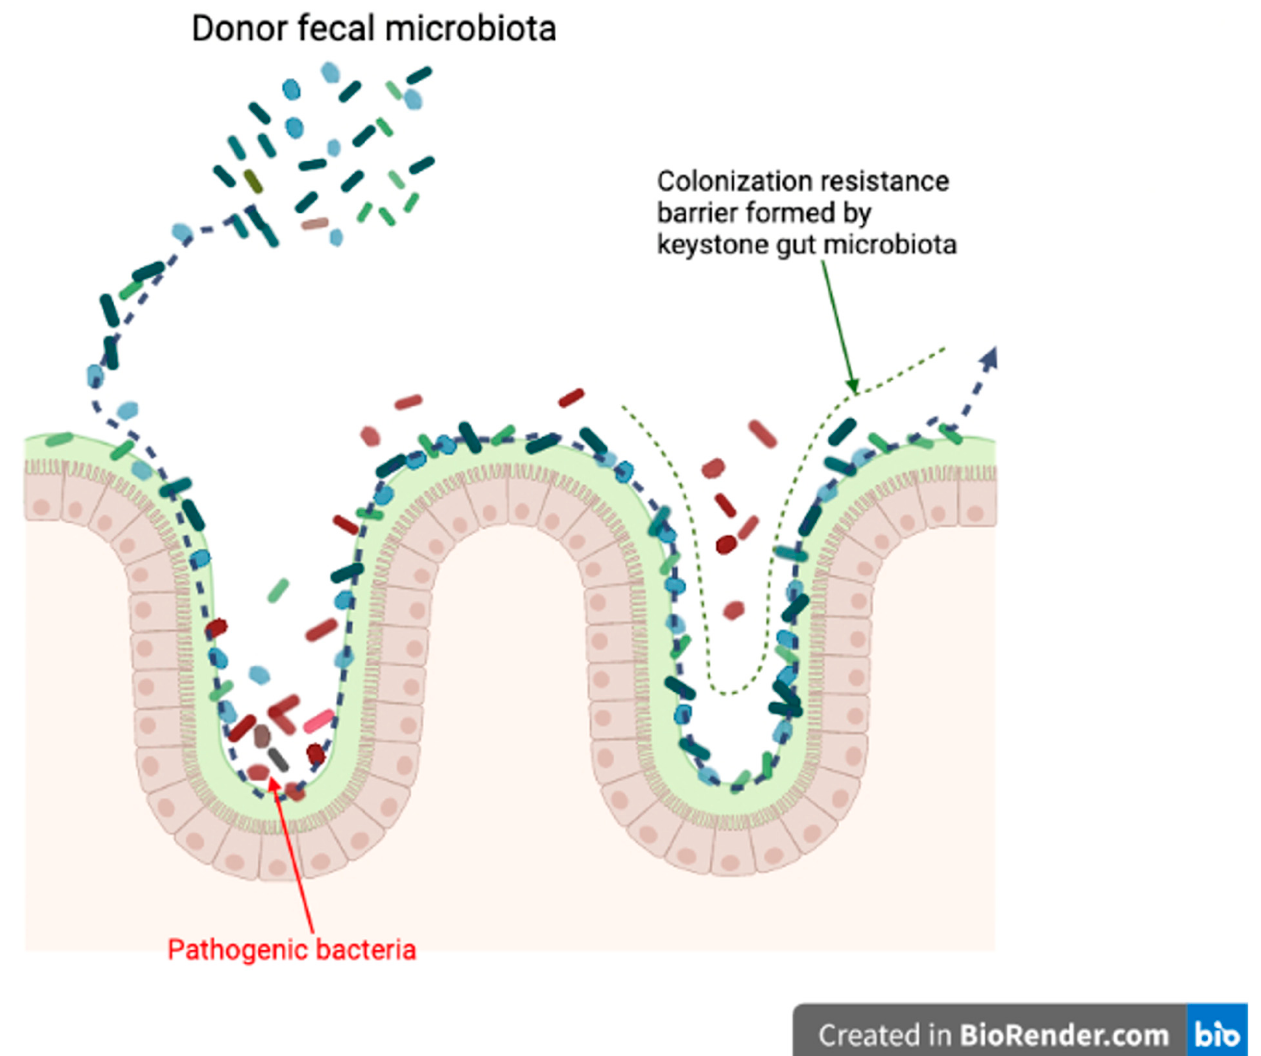
Figure 2. Potential mechanism of FMT; niche exclusion. (Created with BioRender.com).